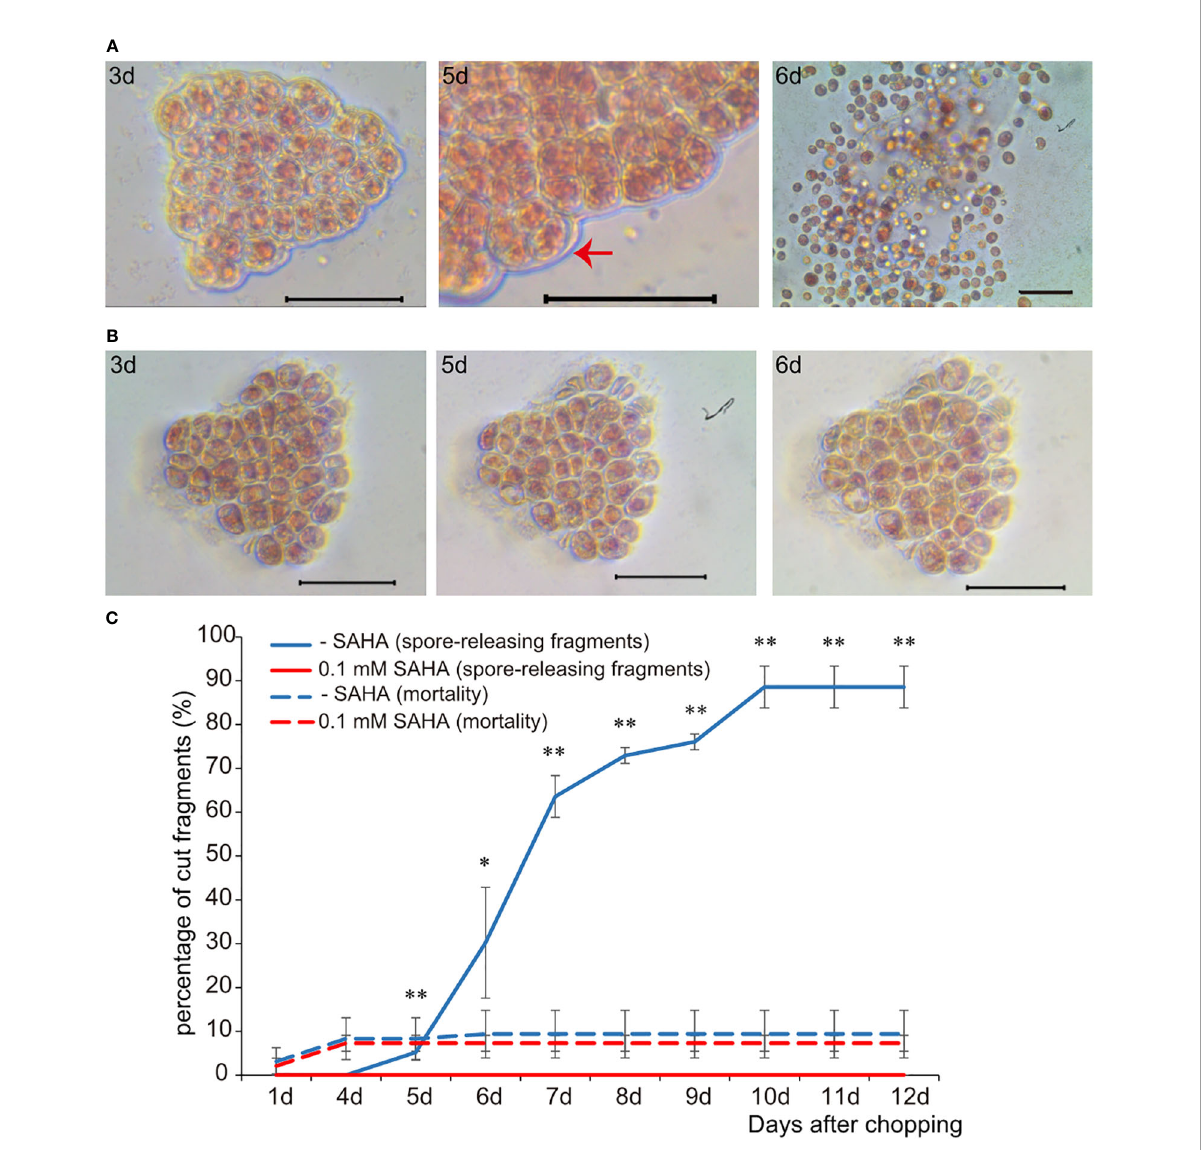
FIGURE 1 The effect of SAHA on the cellular development of wounded P. yezoensis thallus fragments. (A) Morphological changes of the same thallus fragment tracked at 3, 5, and 6 days after wounding. The image of day 5 was zoomed out to show multiple cellular sporangia. (B) Morphological changes of one SAHA-treated fragment tracked at the same time point after wounding. (C) Effects of SAHA on the percentage of cut fragments able to release spores. Average percentages of spore-releasing fragments plotted over time in control and SAHA-treated media; error bars represent the SD (n = 3, 30 fragments/replicate as described in “ Materials and Methods ” section). *, 0.01 < P-value < 0.05; **, P-value <